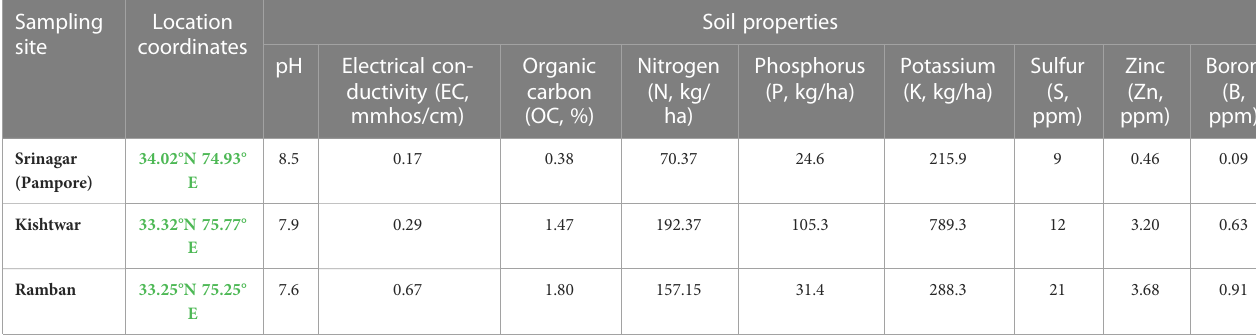
TABLE 2 Location of sampling sites and their soil